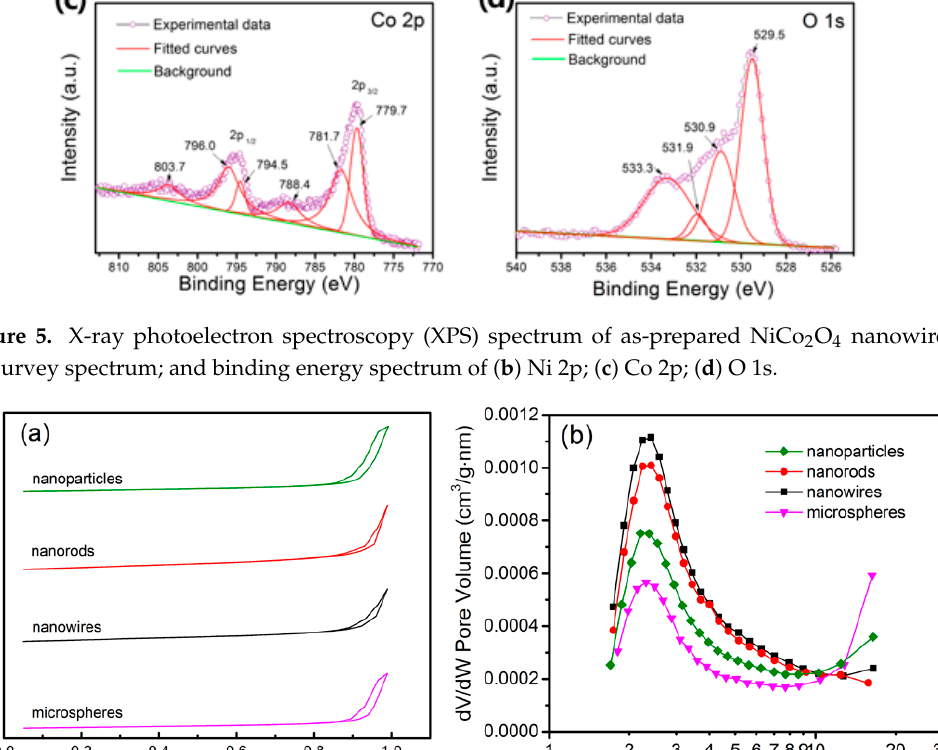
Figure 6. ( a ) N 2 adsorption-desorption isotherm curves and ( b ) pore size distribution curves of the as-prepared NiCo 2 O 4 nanostructures.